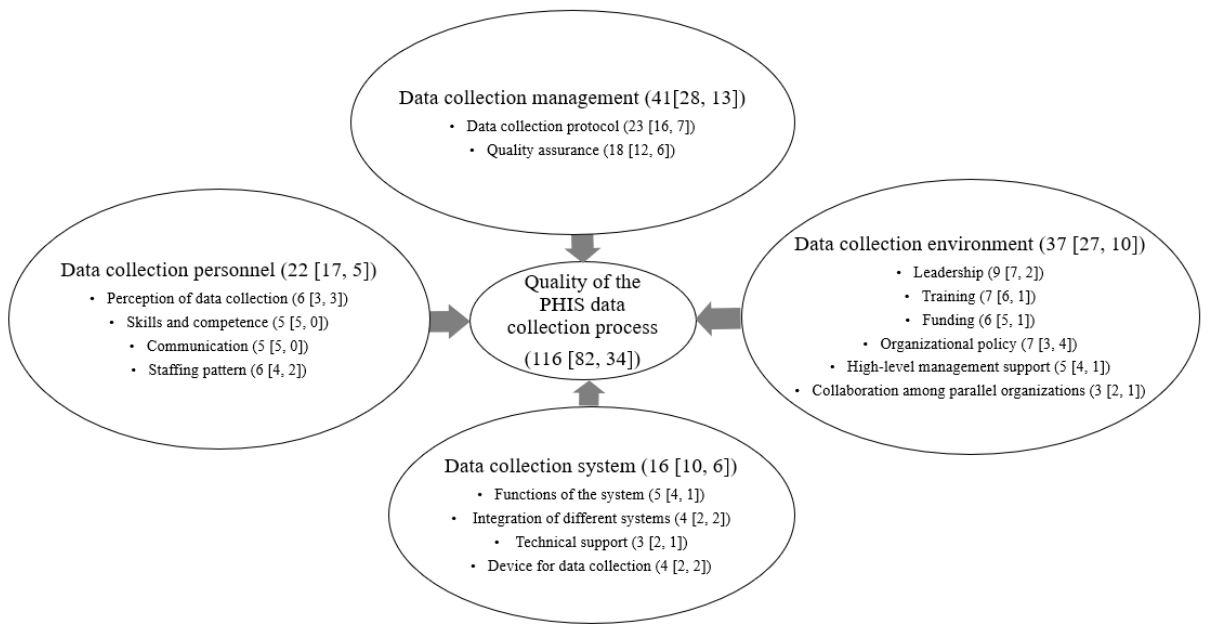
Figure 2. Composition of the 4D framework. Parenthesis: (number of indicators [number of facilitators, number of barriers]). PHIS: public health information